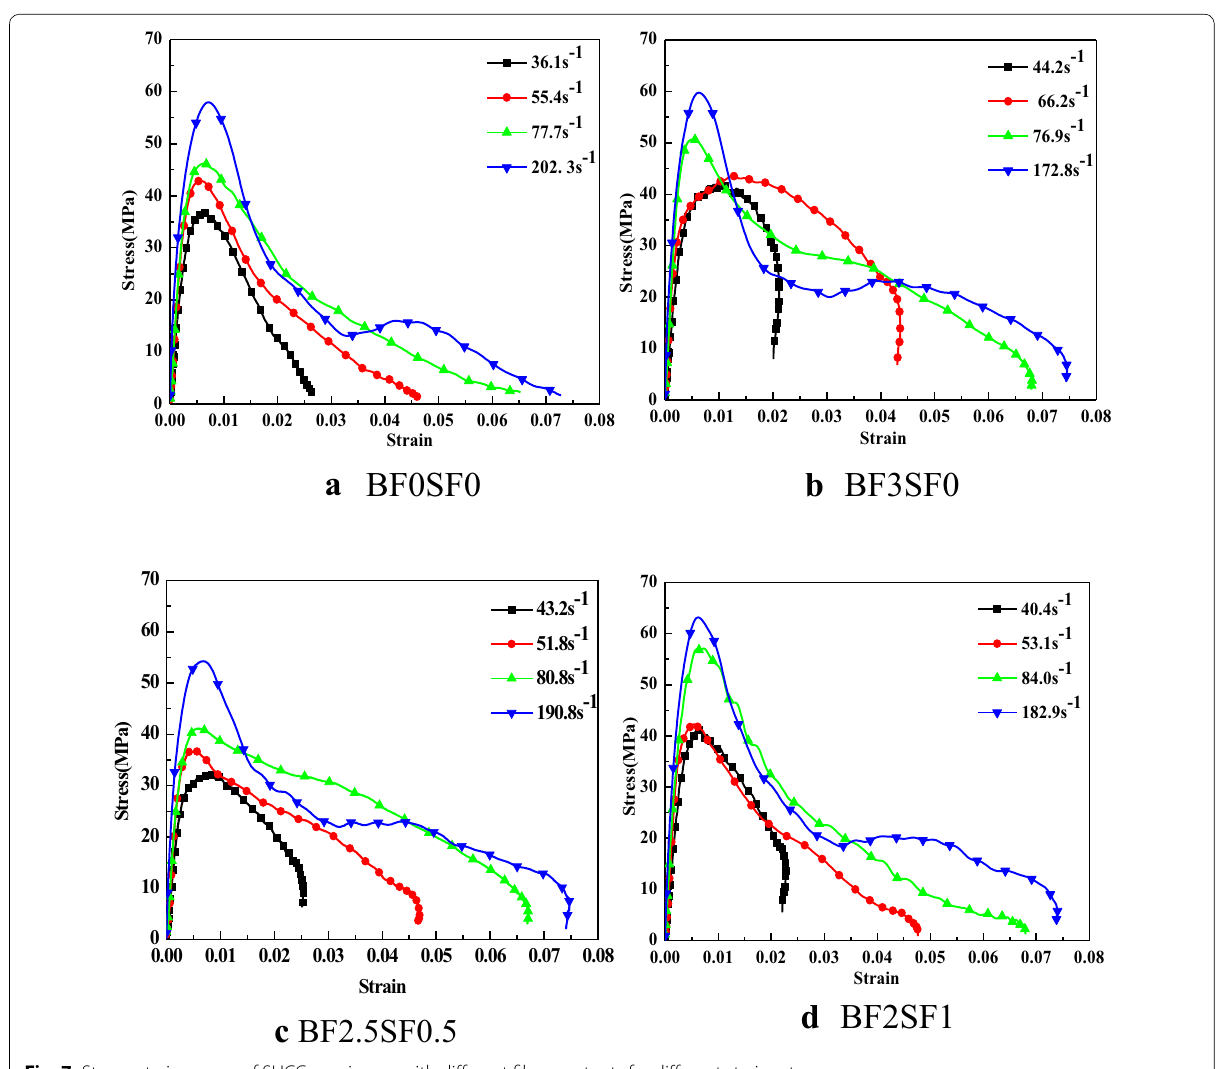
Fig. 7 Stress–strain curves of SHCC specimens with different fiber contents for different strain